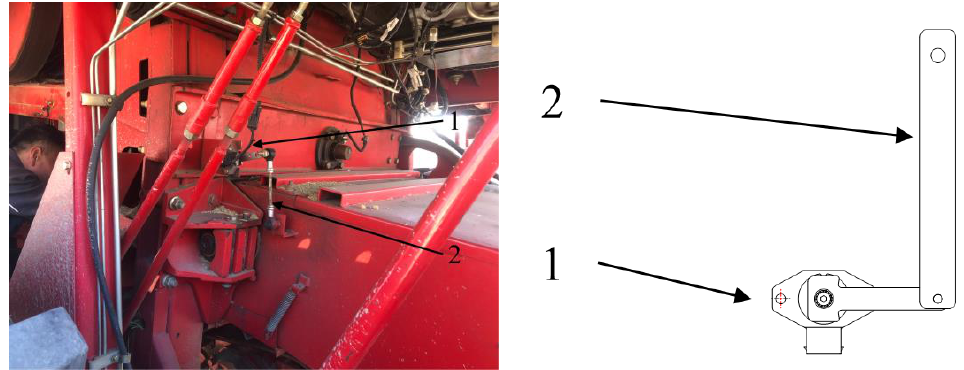
Figure 3. Header height feedback sensing mechanism. 1. Angle sensor; 2. Articulated link.